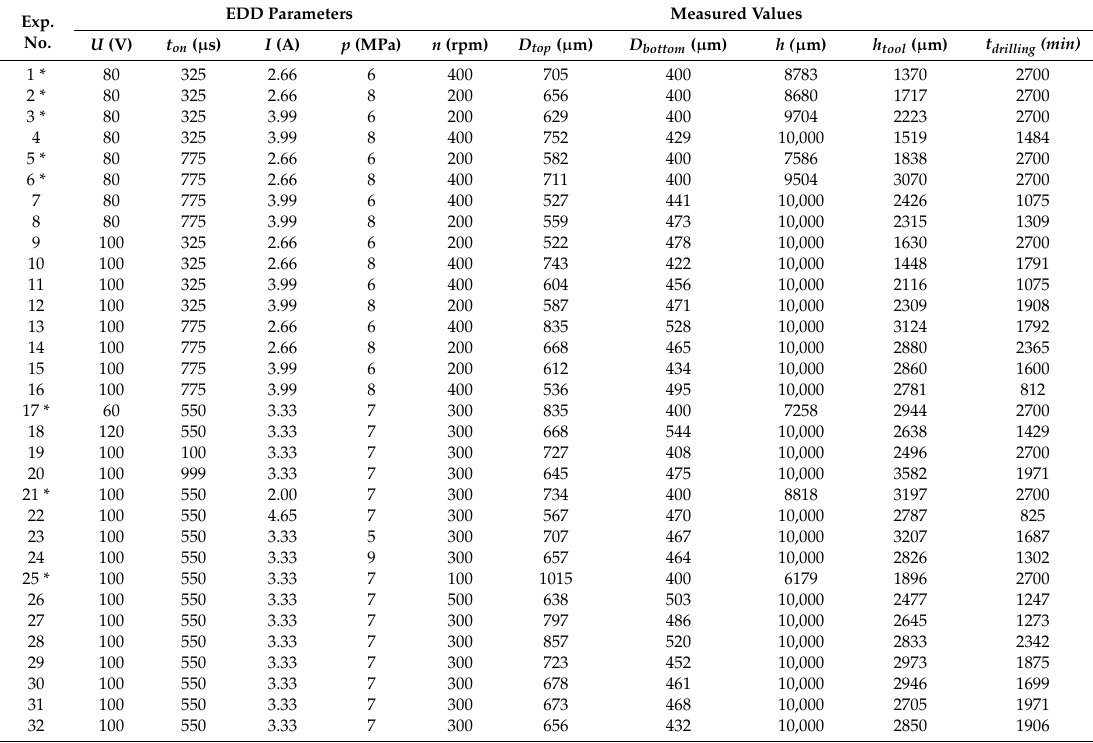
Table 5. Research plan and the results of the experiments. * the blind hole.